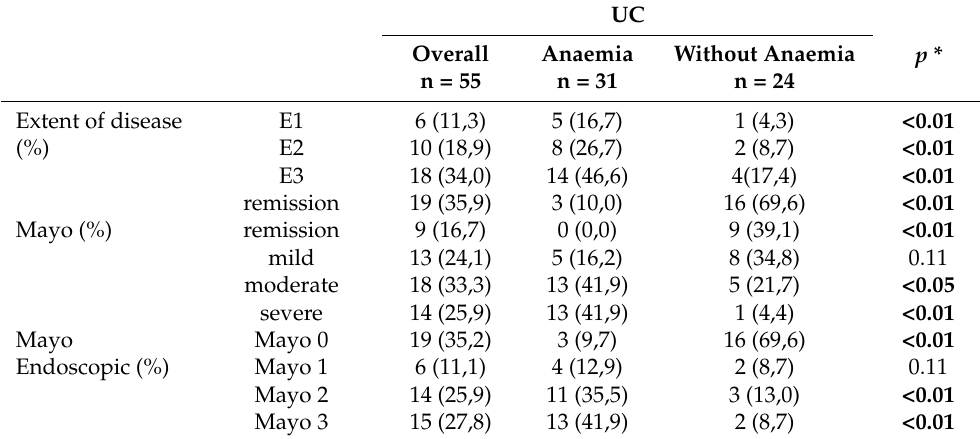
Table 3. Clinical characteristics of patients with UC with and without